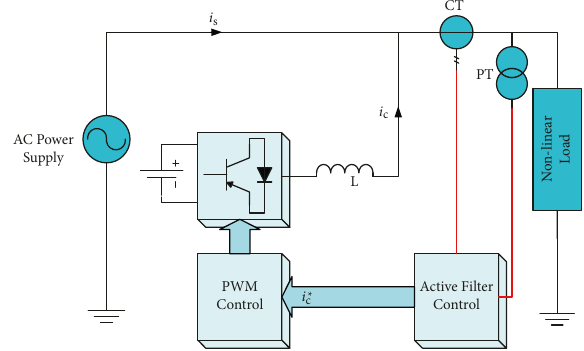
Figure 3: Basic block diagram of a shunt active power